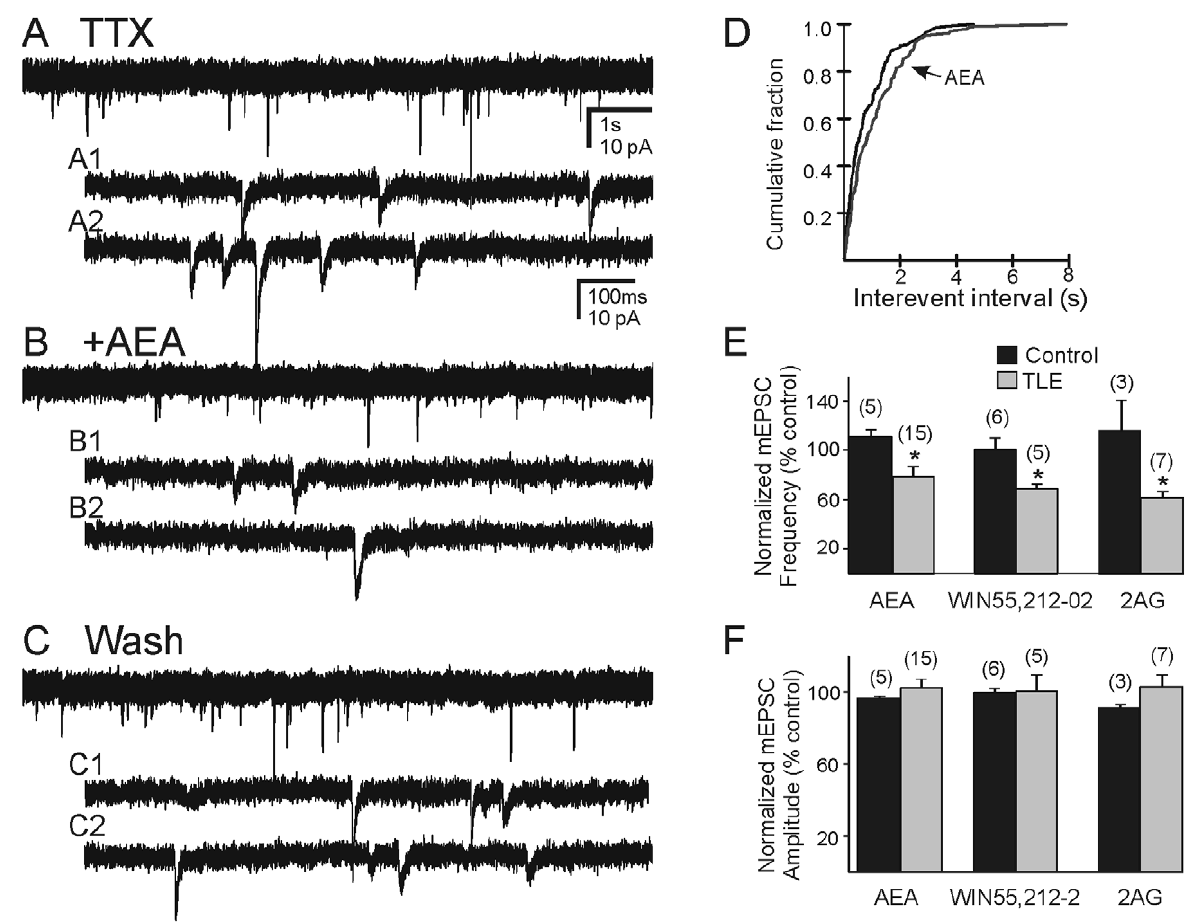
Figure 5. Effect of cannabinoid agonists on TTX-independent mEPSCs in pilocarpine-treated mice that survived SE. A . mEPSCs recorded from a granule cell in the presence of TTX (1 m M). B . Trace showing the reduction of mEPSC frequency after application of AEA (10 m M). C . Wash to TTX alone (20 min) showing that the effect was reversible. A1 , A2 , B1 , B2 and C1 , C2 are expanded segments of A , B and C , respectively. Recordings were made in the presence of bicuculline (30 m M). D . Cumulative probability plot showing a change in the frequency of mEPSCs in this cell. E and F . Cumulative charts showing effect of AEA, WIN 55,212-2 and 2-AG on mEPSC frequency ( E ) and amplitude ( F ) on pilocarpine-treated (TLE) and control mice. Asterisk indicates significant change in mEPSC frequency (p , 0.05); number of recordings shown in parentheses.